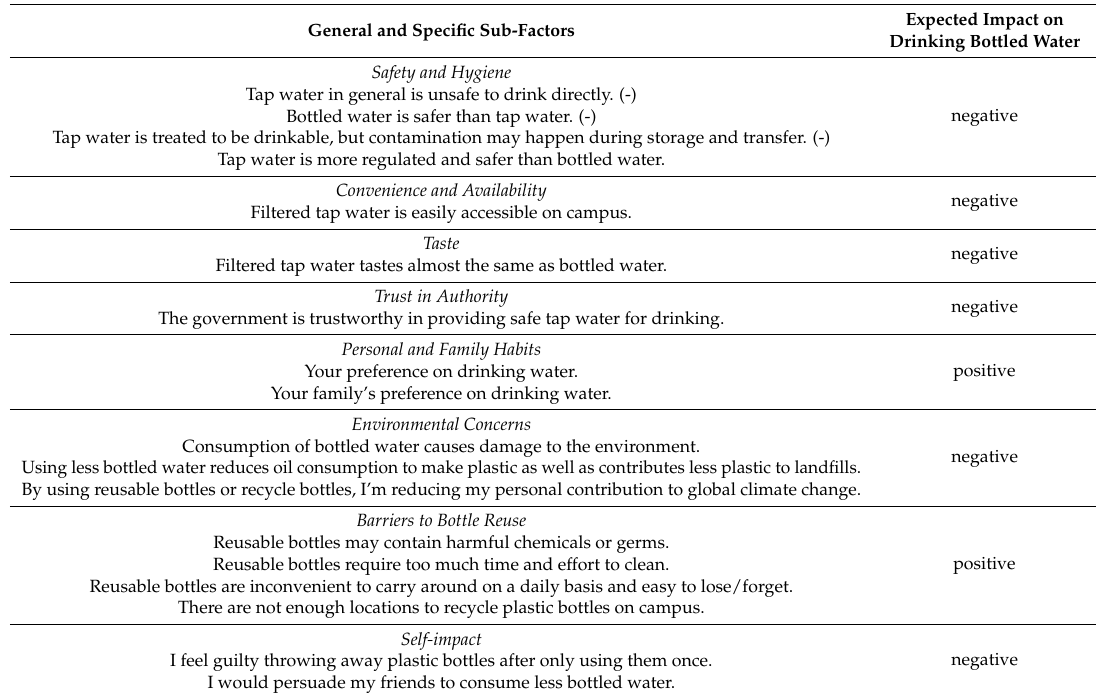
Table 4. Specific factors for drinking water